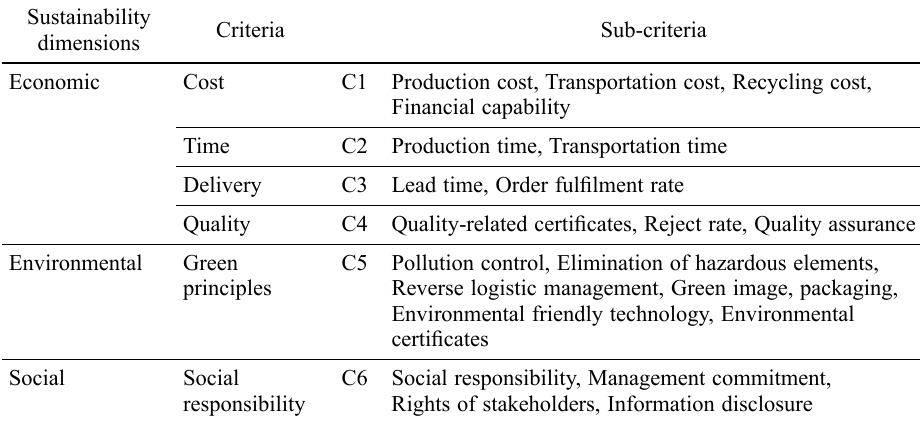
Table 3. Criteria and sub-criteria for supplier